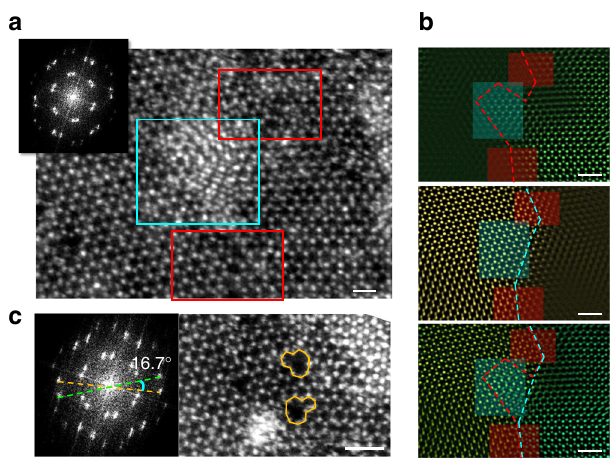
Fig. 3 ADF-STEM images of the grain boundary in monolayer NbSe 2 . a A tilted grain boundary with misorientation angle of 11°. Both atomically sharp lateral interconnected ( red rectangle ) and vertically stacked ( blue rectangle ) boundary regions are found to coexist. The inset shows the fast Fourier transformation ( FFT ) of the image. The distorted polygons are also highlighted in the red rectangle . Scale bar , 0.5 nm. b Selected FFT- fi ltered image of the two domains and their overlap images. The overlapped image con fi rms the coexistence of the two types of grain boundaries. Scale bar , 1 nm. c Similar tilted grain boundary without an overlapping region nearby. The orange lines indicate the fi ve-seven dislocation pairs, which is consistent with the theoretical predictions of the grain boundary